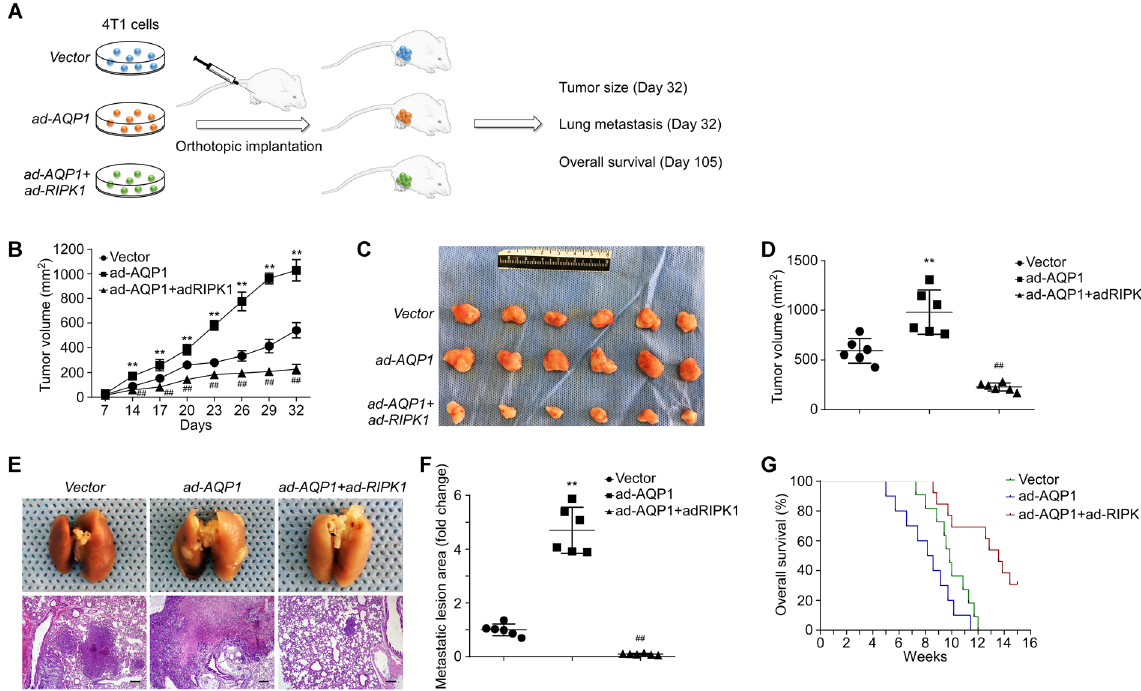
Fig. 5 Upregulation of RIPK1 attenuates AQP1-driven TNBC progression and lung metastasis in vivo. A Flow chart of the in vivo orthotopic breast carcinoma model establishment and experiments. B Statistical analysis of consecutive tumor volume measurements until 32 days after 4T1 cell implantation ( n = 6 for each group). C Representative images of tumors in empty-vector control, AQP1-overexpressing, AQP1 – RIPK1- overexpressing 4T1 cell transplanted BALB/c mice. D Statistical analysis of the fi nal tumor volume measurements at 32 days after 4T1 cell implantation ( n = 6 for each group). E Representative images of gross lung and micrometastatic nodules (×40 magni fi cation) from empty- vector control, AQP1-overexpressing, AQP1 – RIPK1-overexpressing 4T1 cell transplanted BALB/c mice. Scale bar : 200 μ m. F Statistical analysis of the metastatic lesion area measurements at 32 days after 4T1 cell implantation ( n = 6 for each group). G Kaplan – Meier survival plot showing the overall survival of BALB/c mice orthotopically injected with empty-vector control, AQP1-overexpressing, AQP1 – RIPK1-overexpressing 4T1 cells ( n = 11 for each group). Abbreviations : ad-AQP1, AQP1 overexpression; ad-RIPK1, RIPK1 overexpression. Note : ** p < 0.01 vs. empty- vector control; ## p < 0.01 vs. ad-AQP1